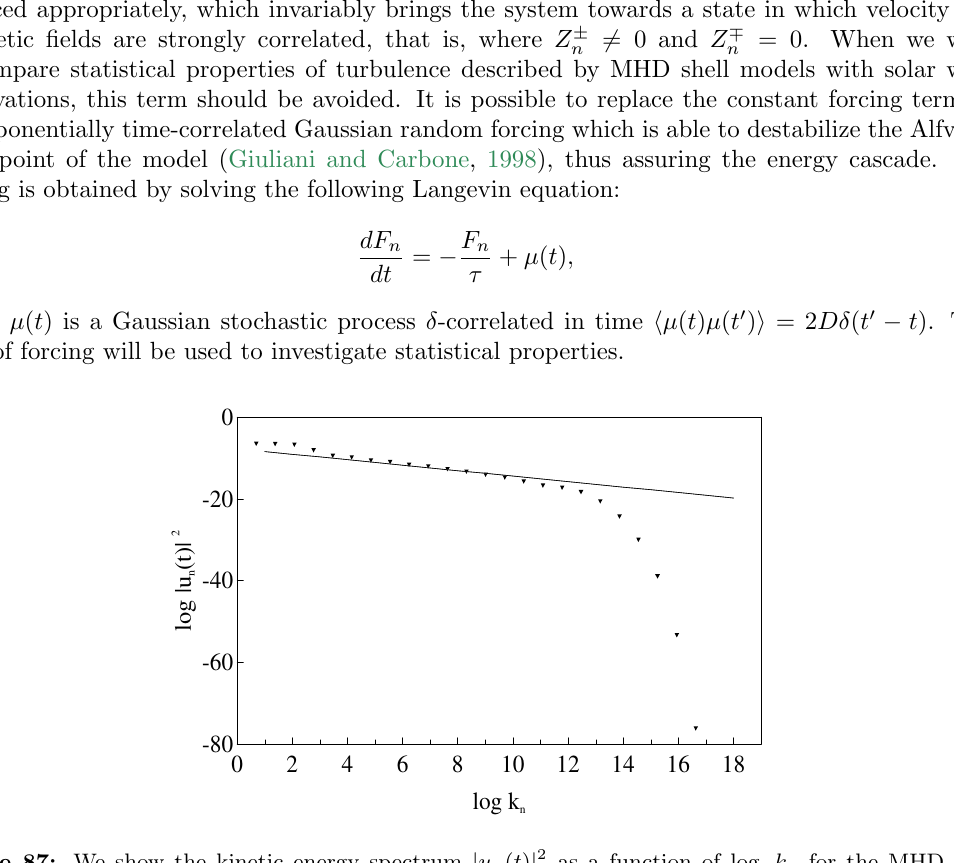
𝑘 𝑛 for the MHD shell 2